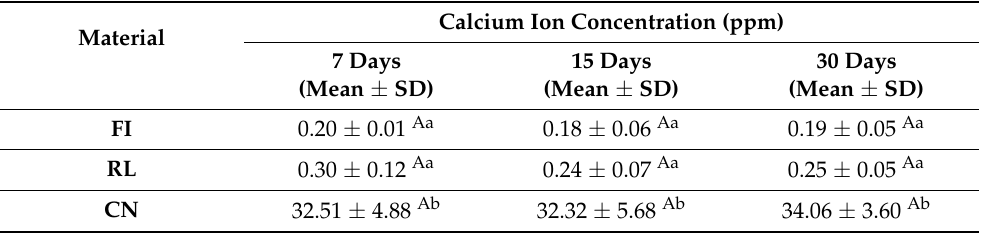
Table 2. Ca ion concentration of each restorative material .